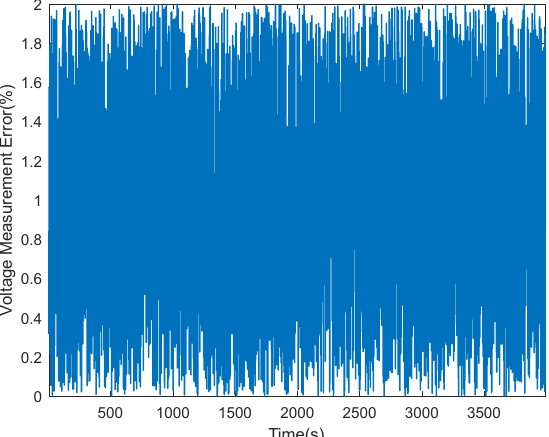
Figure 20. Voltage measurement error during dynamic current with disturbance.